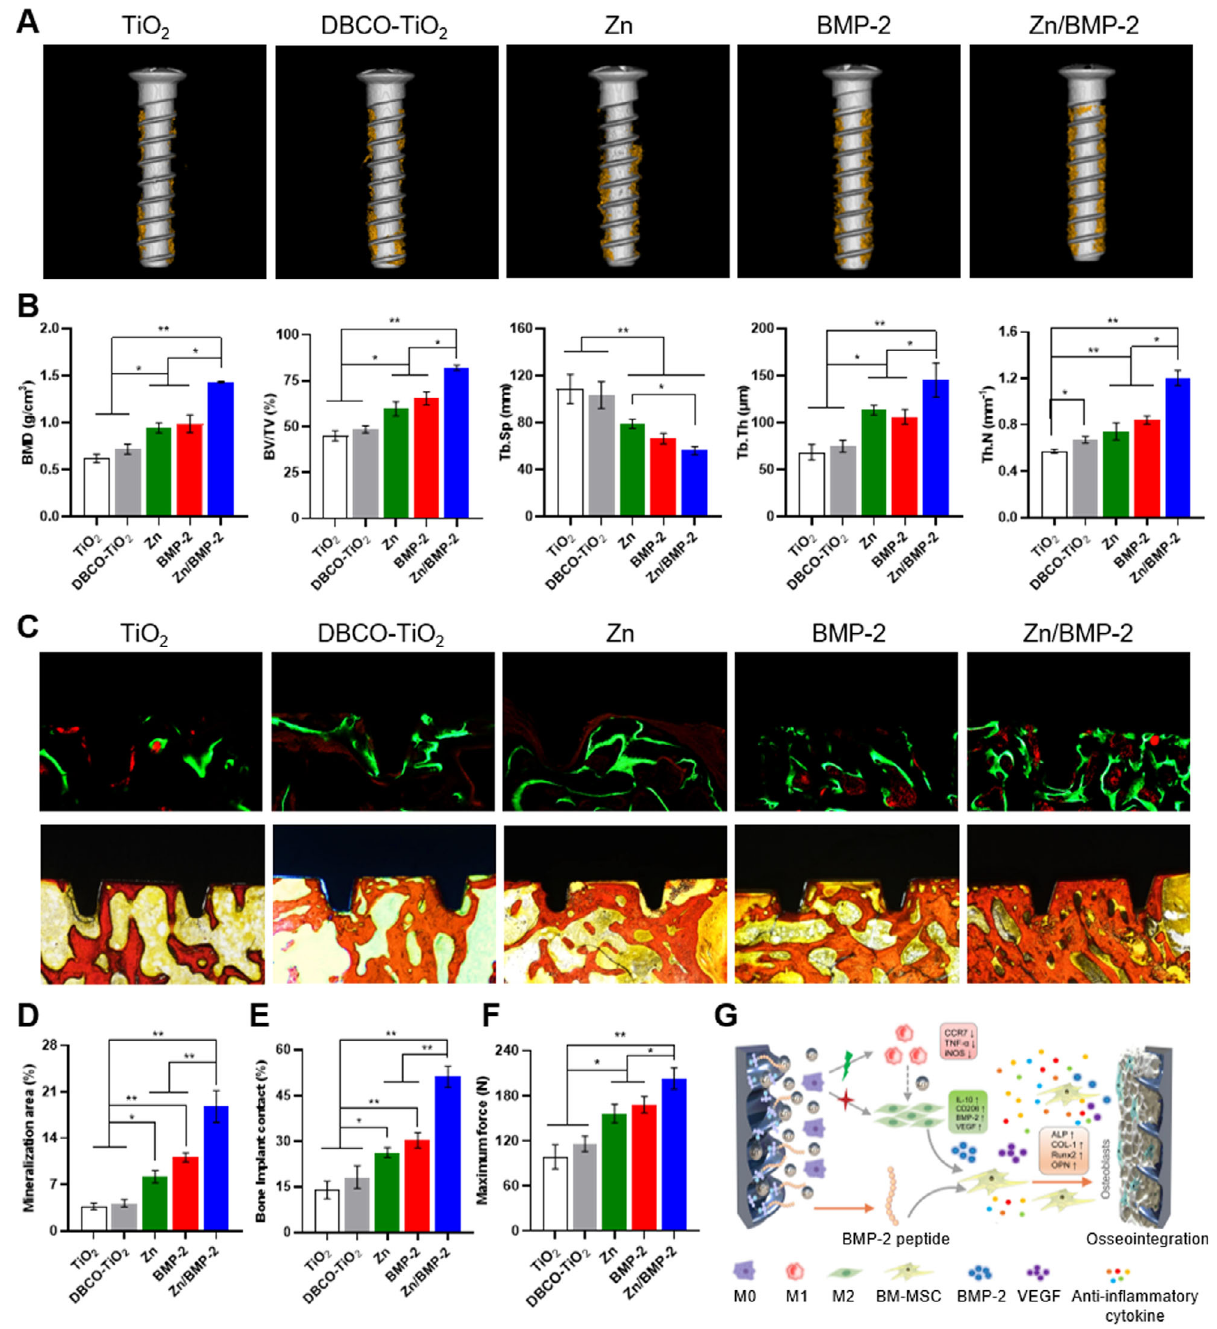
Fig. 7 Micro-CT and histological analysis on osseointegration between bone tissue and screw. A Micro-CT 3D reconstructed images and ( B ) quantitatively evaluating the peri-implant bone generation according to the BMD, BV/TV, Tb.Sp, Tb.Th and Tb.N ( B n = three biologically independent samples per group, by a one-way ANOVA with a Tukey ’ s post hoc test for multiple comparisons). C – E Calcein-Alizarin Red staining for the newly formed bone and ( D ) quantitative staining analysis; Van Gieson and bone implant contact (BIC). F Maximum fi xation force in different groups determined by pull- out testing. G Schematic of the bone regeneration mechanism by enabling M2 phenotype switching and osteoinductivity ( D – F n = 3 independent samples per group, by a one-way ANOVA with a Tukey ’ s post hoc test for multiple comparisons). Data are reported as mean ± SD; * p < 0.05, ** p < 0.01. Exact P values were given in the Source Data fi